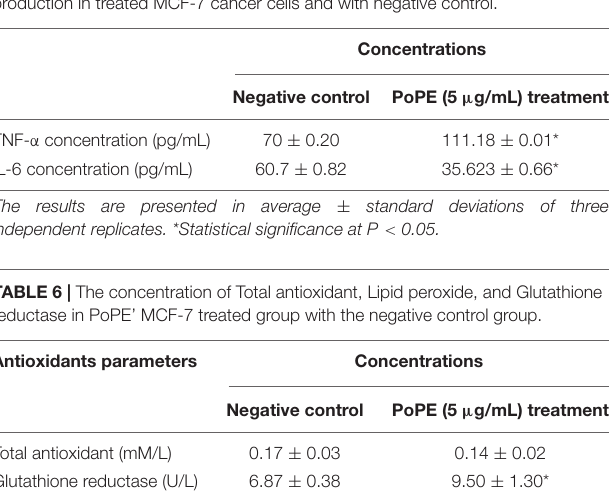
TABLE 5 | Polar extract of Pleurotus ostreatus effects on IL-6 and TNF- α production in treated MCF-7 cancer cells and with negative control.